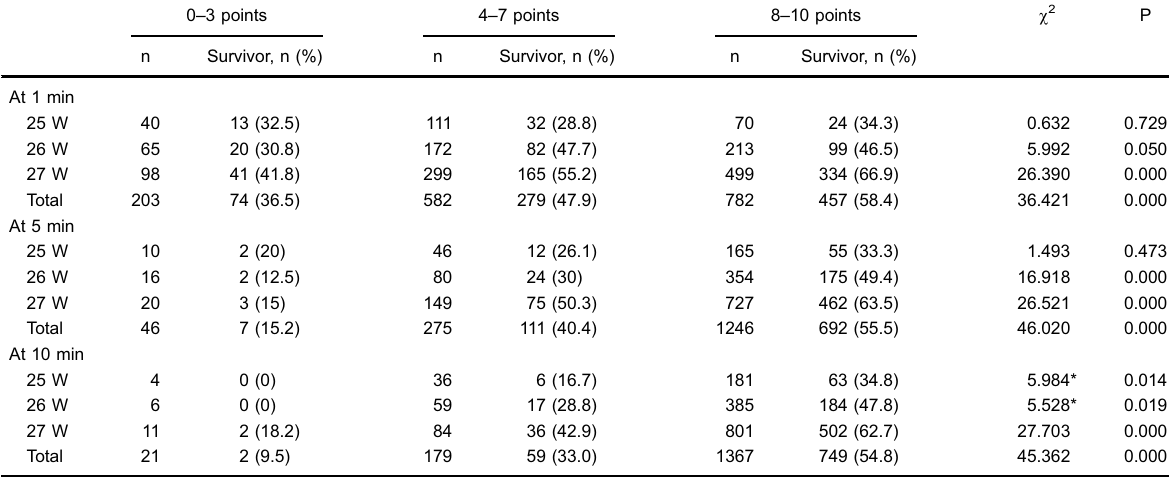
Table 2. Survival rate at discharge according to Apgar score and gestational